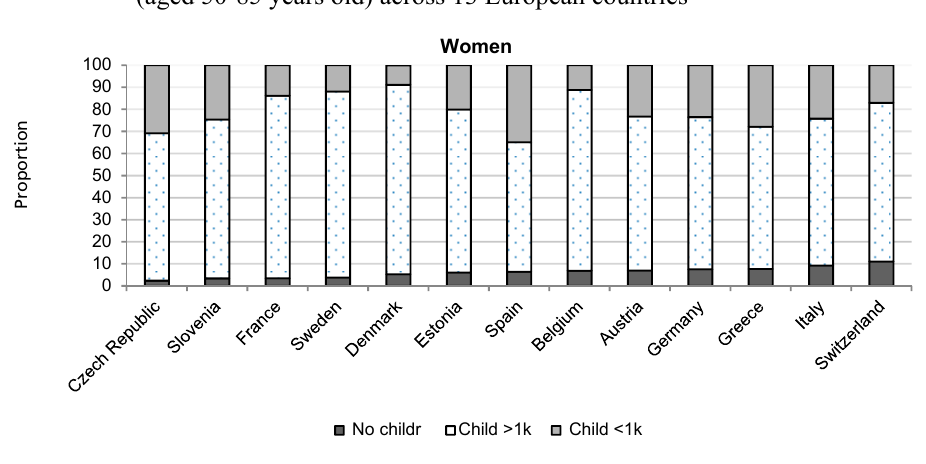
Figure 2 : Prevalence of parenthood among men and women (aged 50-85 years old) across 13 European